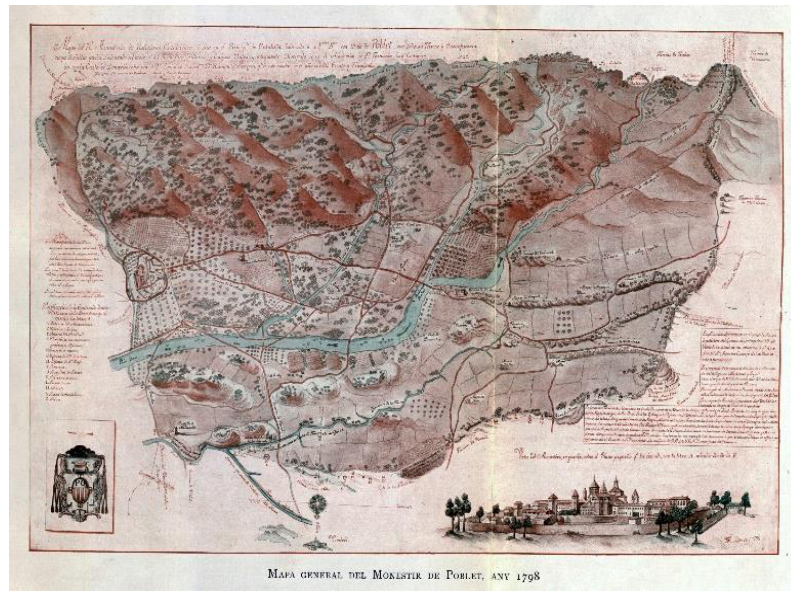
Figure 8. General map of Poblet Monastery in 1798.